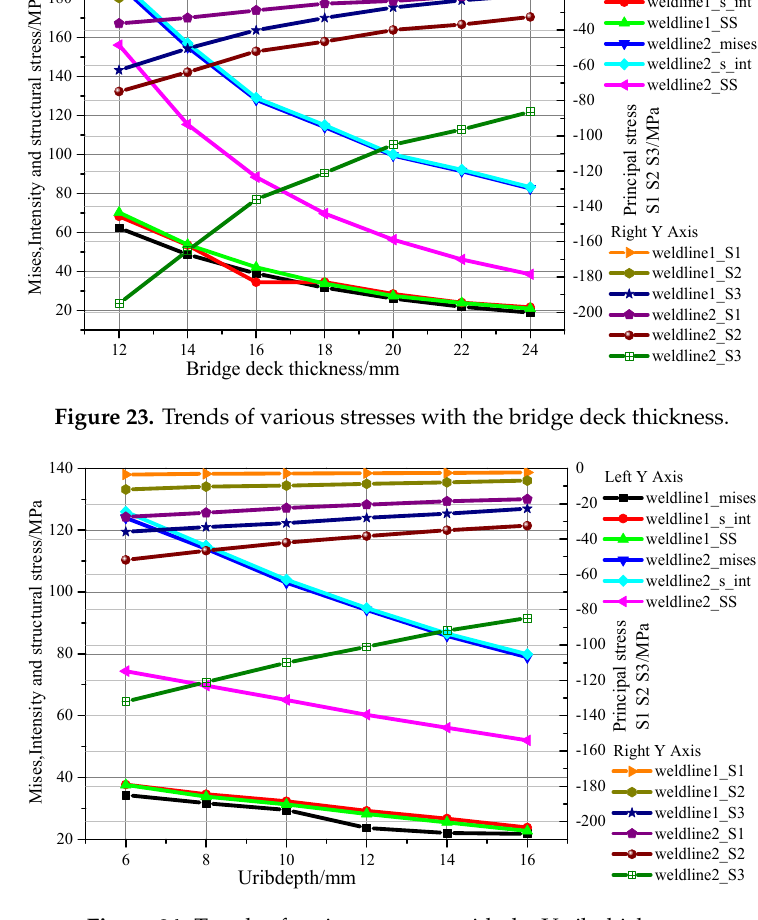
Figure 24. Trends of various stresses with the U-rib thickness.